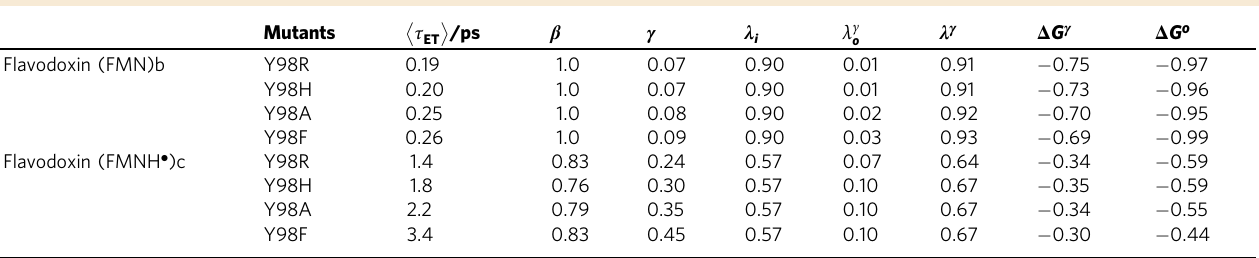
Table 1 Energetics of forward electron transfer reactions in fl avodoxin a .